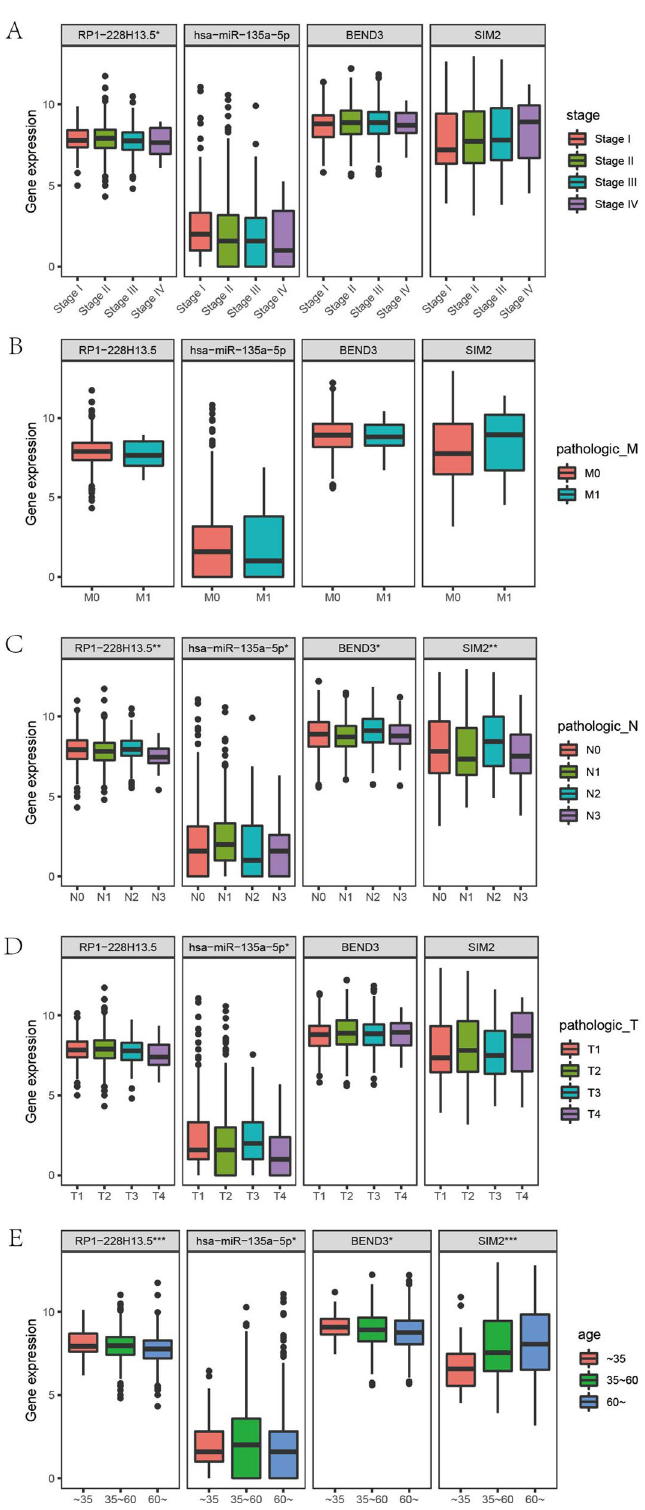
Figure 10. Clinical correlation analysis of key genes in ceRNA network. ( A – E ) Correlation analysis between key genes and clinical stage, pathological metastasis stage, pathological N stage, pathological T stage and age at initial pathologic